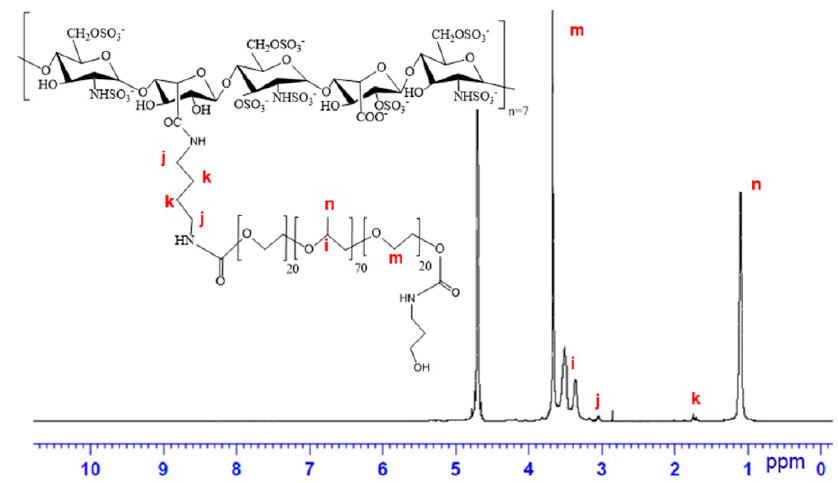
Figure 1. 1 H-NMR spectrum of Hep-P123 copolymer. Letters on the spectrum indicate to which protons in the Hep-P123 molecule the signals correspond.